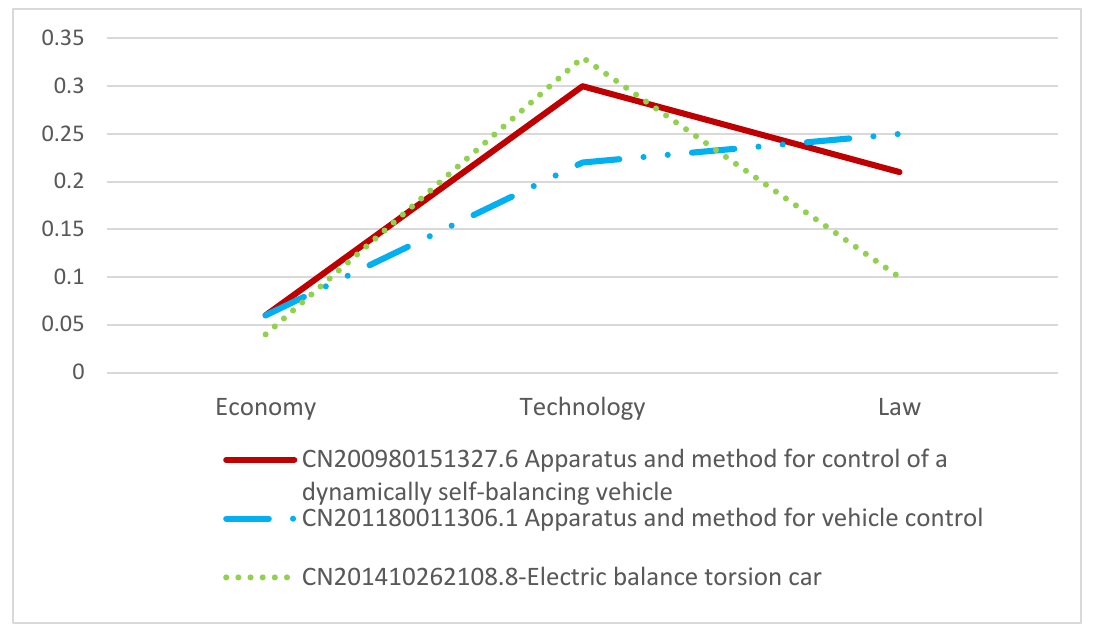
Figure 5. The patent measurement line chart of the top three measurement results.